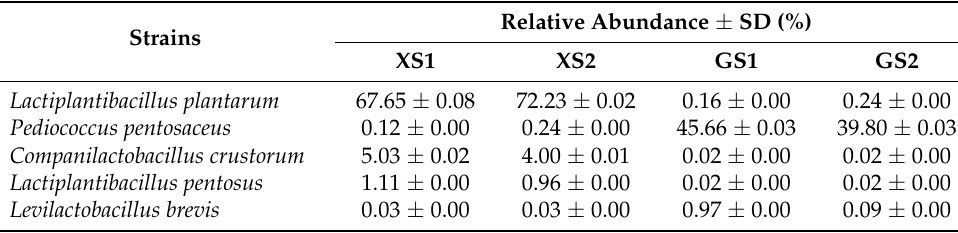
Table 5. Relative abundance of different sourdough samples at the classification species level.